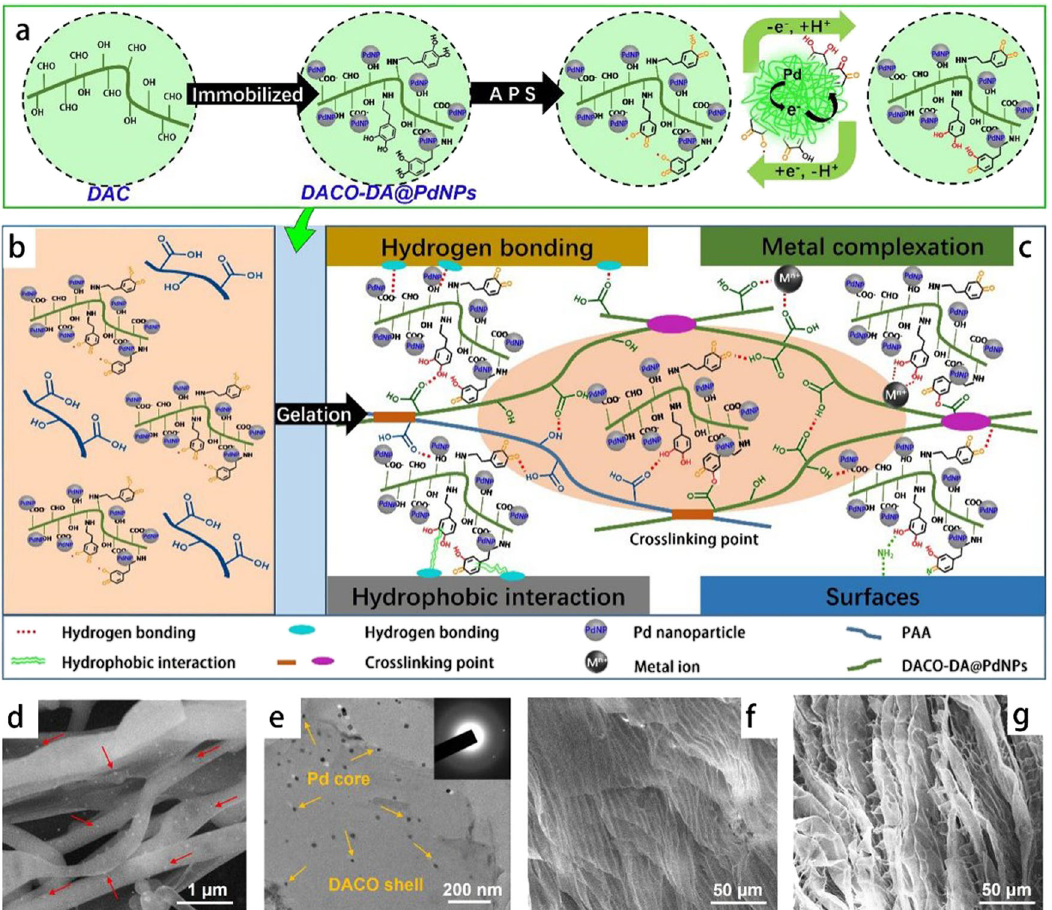
Fig. 2 Design strategy of high-viscosity DACO-PDA-PAA@Pd NPs hydrogels. a Immobilization of Pd NPs on the surface of the DACO-PDA, and the generation of free radicals by the redox reaction between the DACO-PDA@Pd NPs and APS. Schematic diagrams of the molecular structure model b before and c after polymerization. The following models show what each stage represents. d SEM and e TEM images of Pd NPs loaded on the surface of DACO-PDA fi brils. f , g SEM images of the pure PAA and DACO-PDA-PAA@Pd NPs hydrogels,